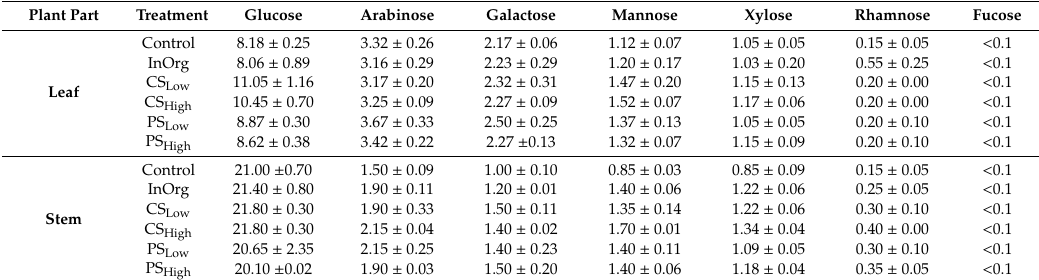
Table 3. Leaf and stem sugar contents from structural carbohydrates (g 100 g − 1 d.m.) in Rosmarinus o ffi cinalis leaves for the fertilization treatments: Control, InOrg, CS Low , CS High , PS Low and PS High . Data are reported as mean values ± standard errors ( n = 3).